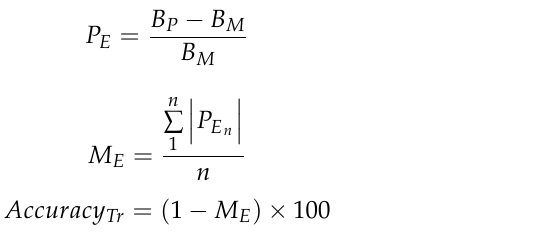
Table 3. Validation of FEA.